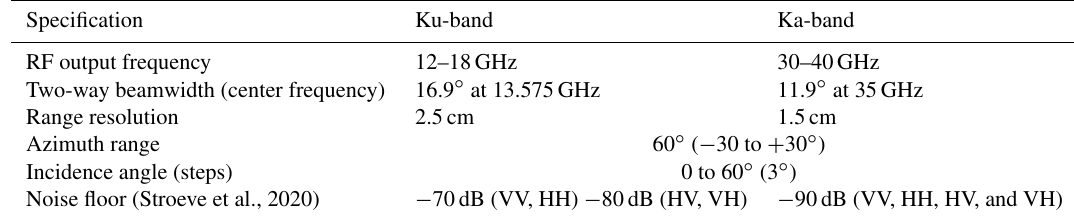
Table 1. Operating parameters for each of the KuKa radar’s radio frequency (RF) units.